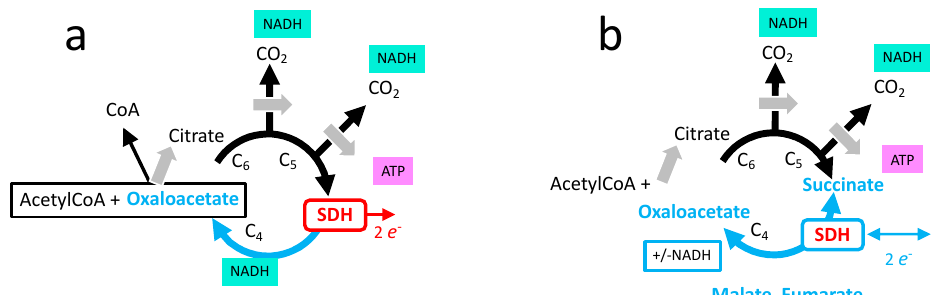
Figure 6. Tricarboxylic acid cycle (TCA). ( a ) Oxidative metabolism: one TCA cycle consumes the two carbons brought by condensation of acetylCoA with oxaloacetate. It ends with the regeneration of oxaloacetate. This implies three steps of NAD reduction into NADH, phosphorylation of one molecule of ADP/GDP into ATP/GTP (shown as ATP), and one reaction of the SDH. ( b ) Three reactions (gray arrows): citrate formation and the two release of CO 2 steps have strong negative ∆ Gs and orient TCA clockwise (oxidation). In contrast, the sequence of reactions between succinate and oxaloacetate are reversible.